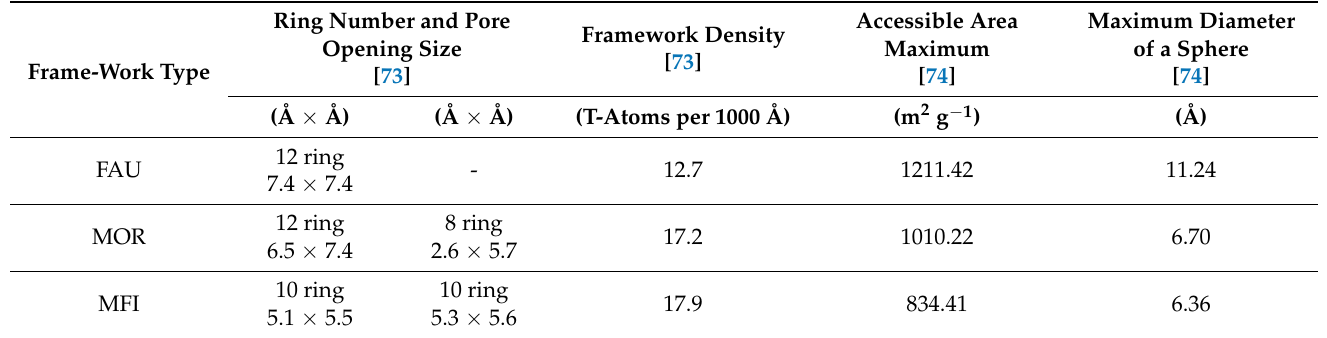
Table 1. Key properties of three commonly used frameworks of